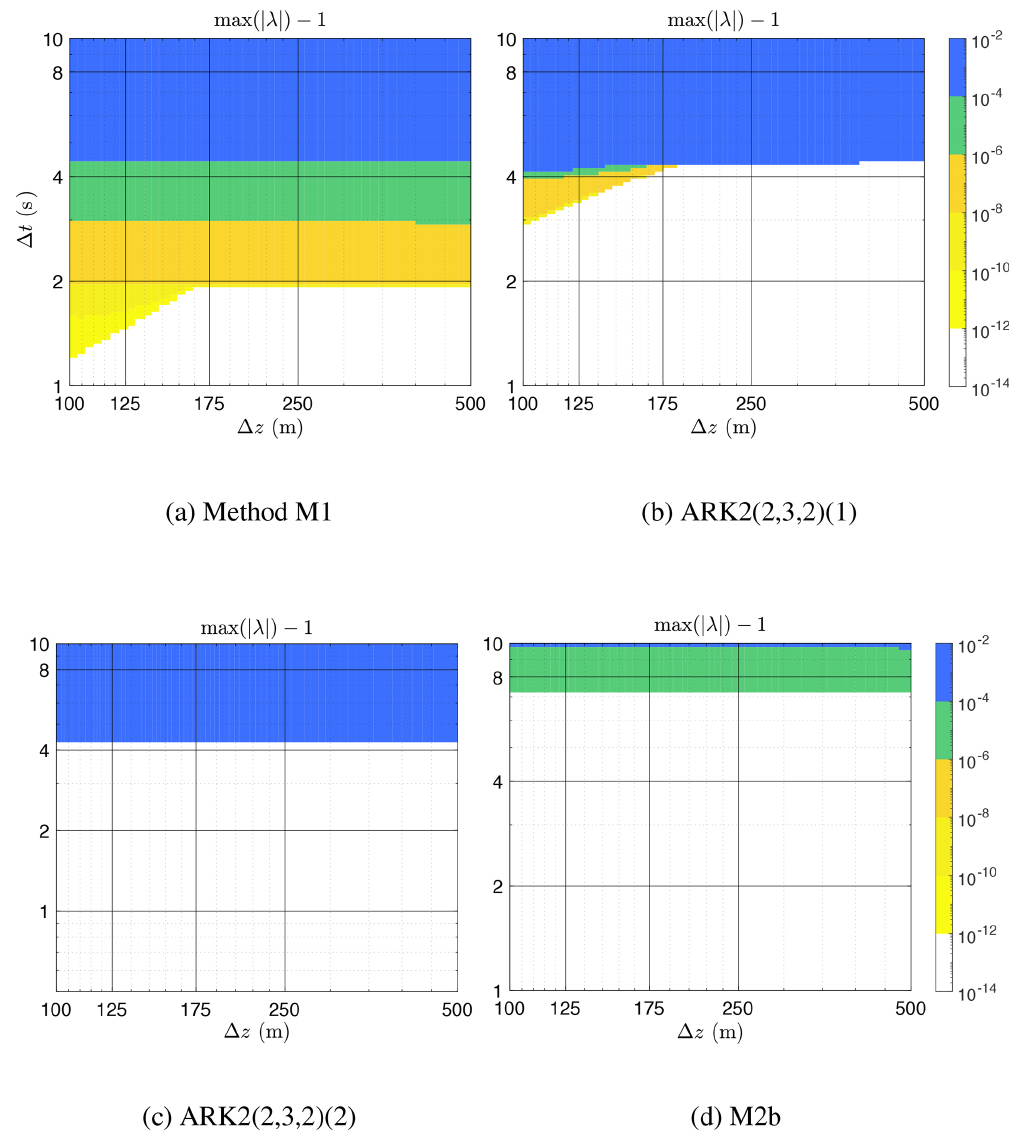
Figure 6. Stability diagrams with respect to varying n lev .